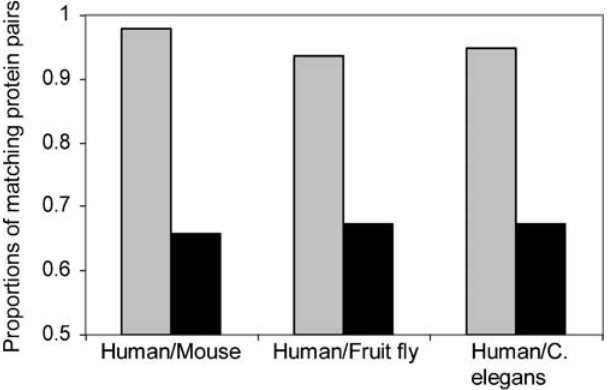
Figure 1. Signal peptide is a conserved feature of homologous proteins. Homologous proteins of human/mouse, human/fruit fly, and human/C. elegans were extracted from HomoloGene triplets. The proportion of matching protein pairs, in which both proteins have or lack a signal peptide, was calculated for each pair of organisms (gray columns). For comparison, the expected proportions (black columns), is calculated under the assumption that signal peptide is not conserved between homologs, using the prevalence of proteins having signal peptides in each organism.